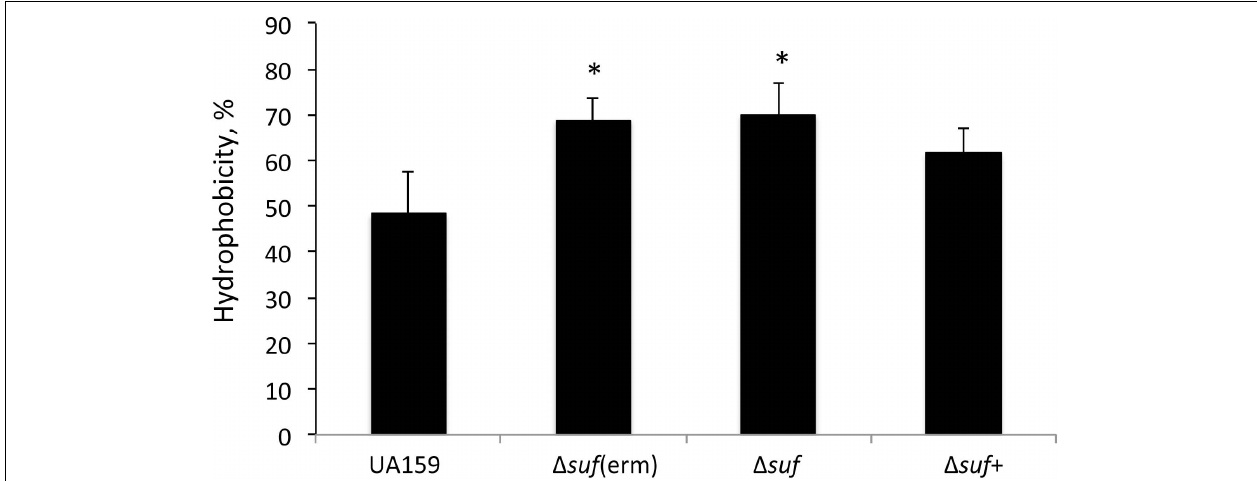
FIGURE 8 | Cell surface hydrophobicity analysis. Streptococcus. mutans wild-type UA159, its (cid:49) suf::erm r [ (cid:49) suf (erm)] and (cid:49) suf::kan r ( (cid:49) suf ), and the complement strain (cid:49) suf + were grown in BHI broth until mid-exponential phase (OD 600 nm ∼ 0.4), harvested by centrifugation, and washed once with phosphate buffered saline. The cell pellets were resuspended in PUM (phosphate, urea, magnesium) buffer and mixed by vigorous vortexing with decane. The OD 400 nm of the aqueous phase was measured and recorded before (A 0 ) and after mixing (A 1 ). The results showed that absence of sufCDSUB resulted in significant increases of surface hydrophobicity with * indicating P <